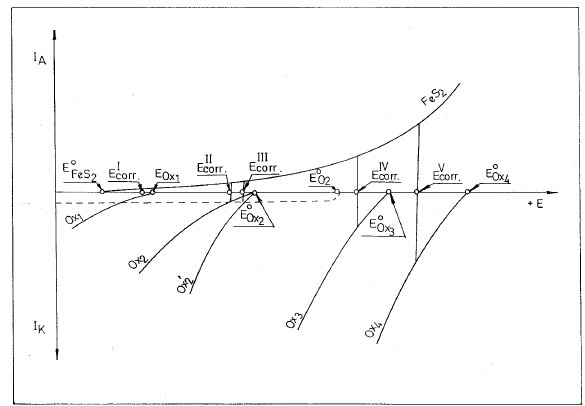
Figure 1. Anodic and cathodic polarization curves by means of which potential changes at the titration end-point are explained [ Ox